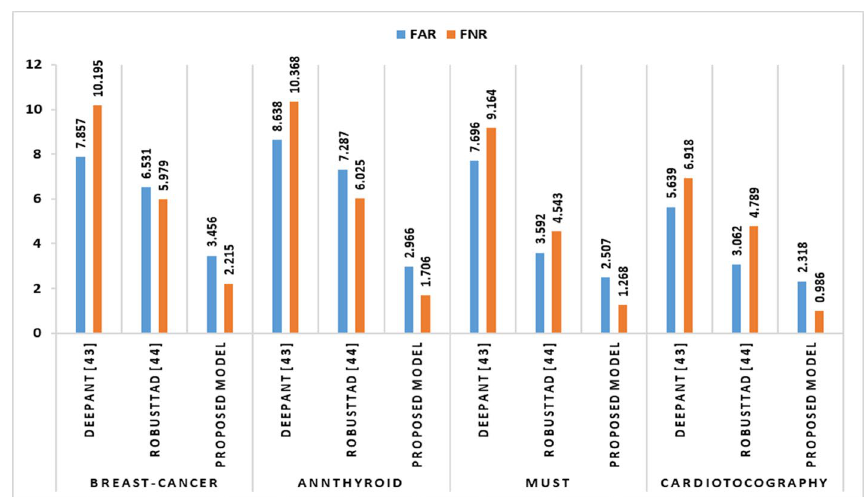
Fig. 6 Performance Metrics (FAR & FNR) of different DL Algorithms